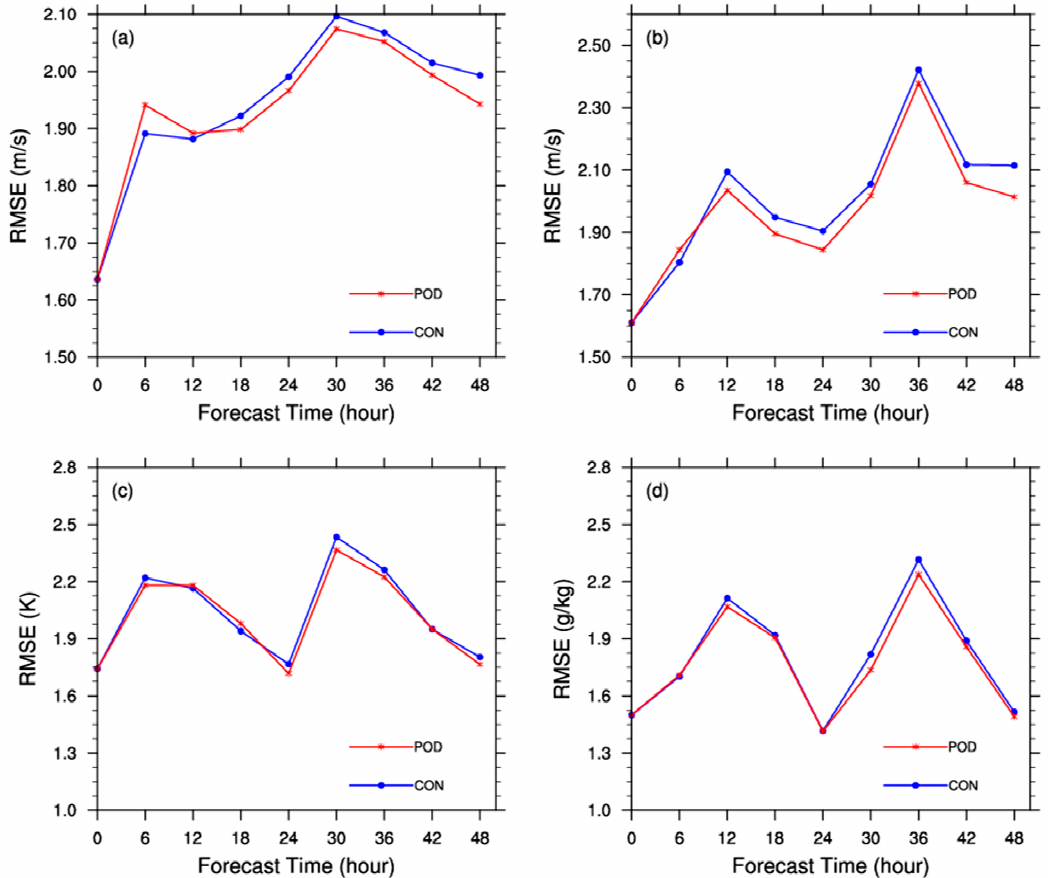
Figure 6. The average RMSE evolution as forecast time increase for ( a ) U at 10 m, ( b ) V at 10 m, ( c ) T at 2 m, and ( d ) Qv at 2 m. The blue line represents results from the baseline experiment (CON) and red represents results from the second experiment (POD).